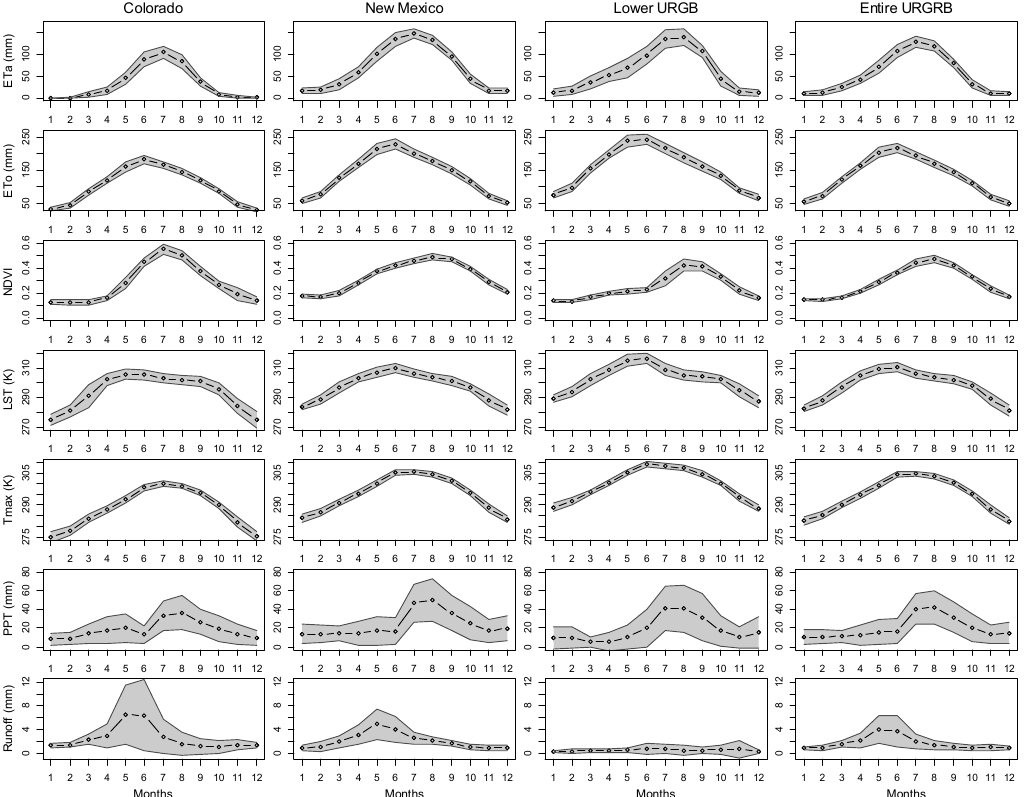
Figure 9. Seasonal patterns of seven agro-hydrologic variables for the cropland portions within each region boundary. The 1986–2015 monthly mean with one standard deviation (in dark grey) for actual evapotranspiration ( ETa ), reference ET ( ETo ), normalized difference vegetation index (NDVI), land surface temperature (LST), maximum air temperature ( Ta ), precipitation (PPT), and runoff.